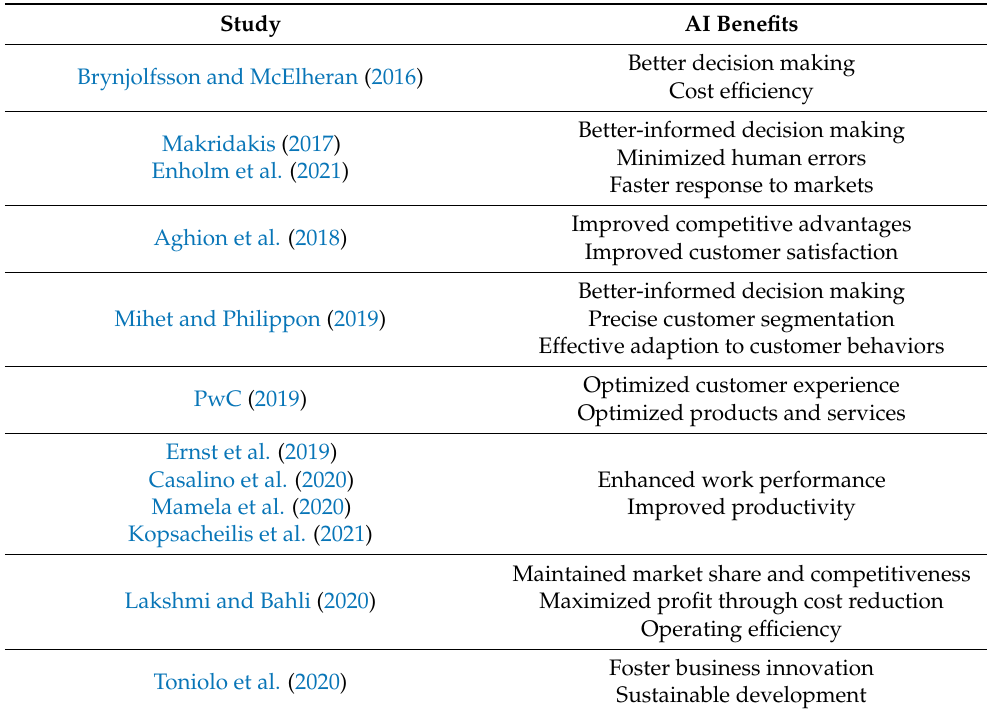
Table 1. Selected studies on the benefits of Artificial Intelligence.